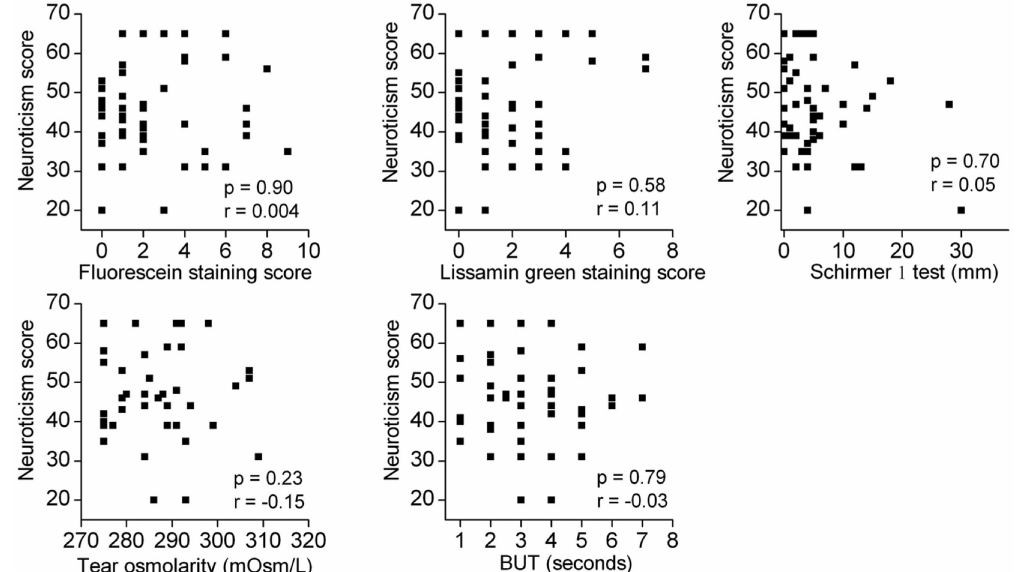
tear osmolarity, and the BUT. No significant correlations were observed for any of the combinations. Similarly, there were no other personalitytraits that exhibitedany significant correlations with the objectivesigns (Data not shown). r; Spearman’s correlationcoefficient.